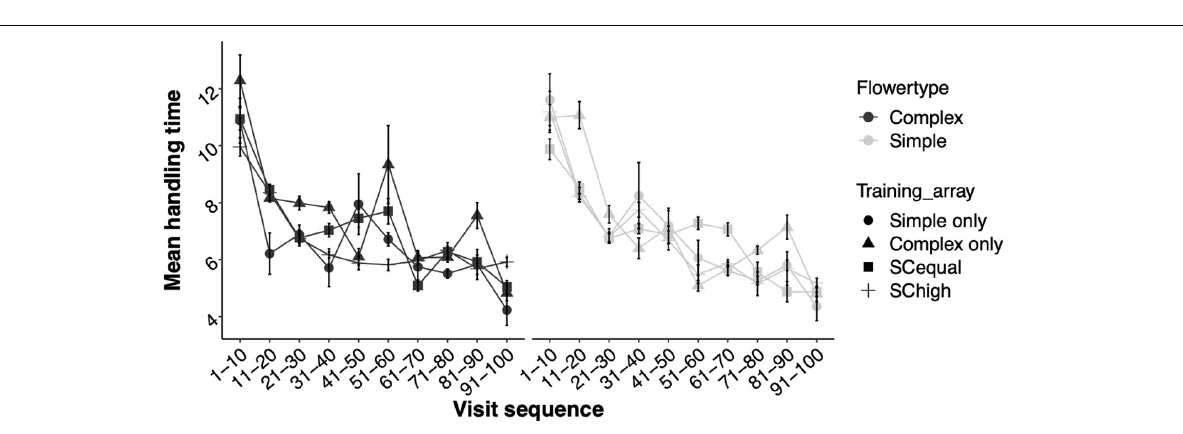
FIGURE 7 | Mean ± SE handling times (in seconds) of complex (black) and simple (gray) flowers throughout the experiment’s test phase. Although aggregated here into 10-visit bins for visual clarity, the handling time of each visit was treated as a data point in the statistical